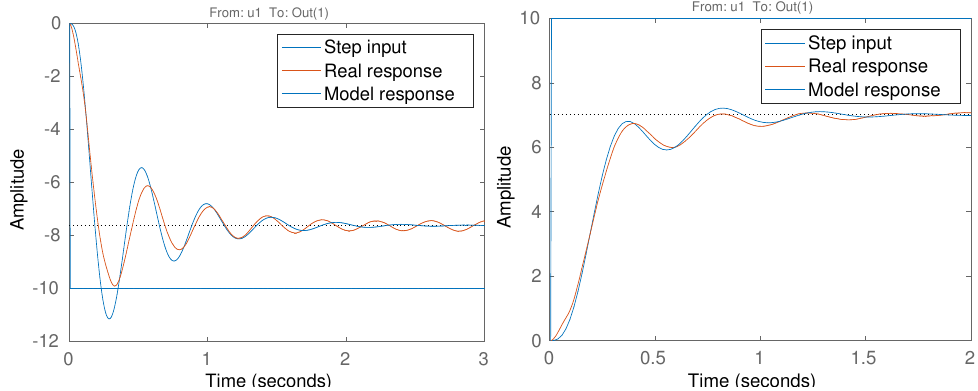
Figure 4. Validation example of the identified models showing two different behaviors. Data obtained from the case of variations in Alpha input ranging from 10 deg to 20 deg (left of Figure 3). Showing the Step input (Alpha input), and the Real response (Alpha output) used in the RLS identification. Resulting model time response is also shown for